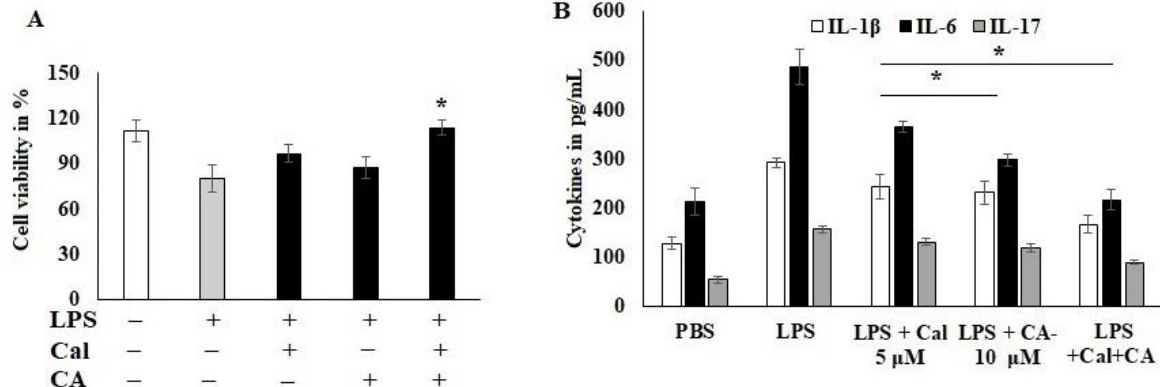
Figure 3. Capric acid and calcitriol effect on LPS-induced HCT116 cell lines. ( A ) LPS-induced HCT116 cell exposed to CA 10 μM and Cal 5 μM alone and its synergistic therapy for 24 h. The cellular viability was quantified by CCK8 kit. ( B ) cytokines IL-1 β , IL-6 and IL-17 were quantified using Invitrogen cytokine estimation kit. Data were obtained from three separate experiments and expressed as mean ± SEM. * p < 0.05 represents significance compared to treated group (CA and Cal) against PBS (untreated group